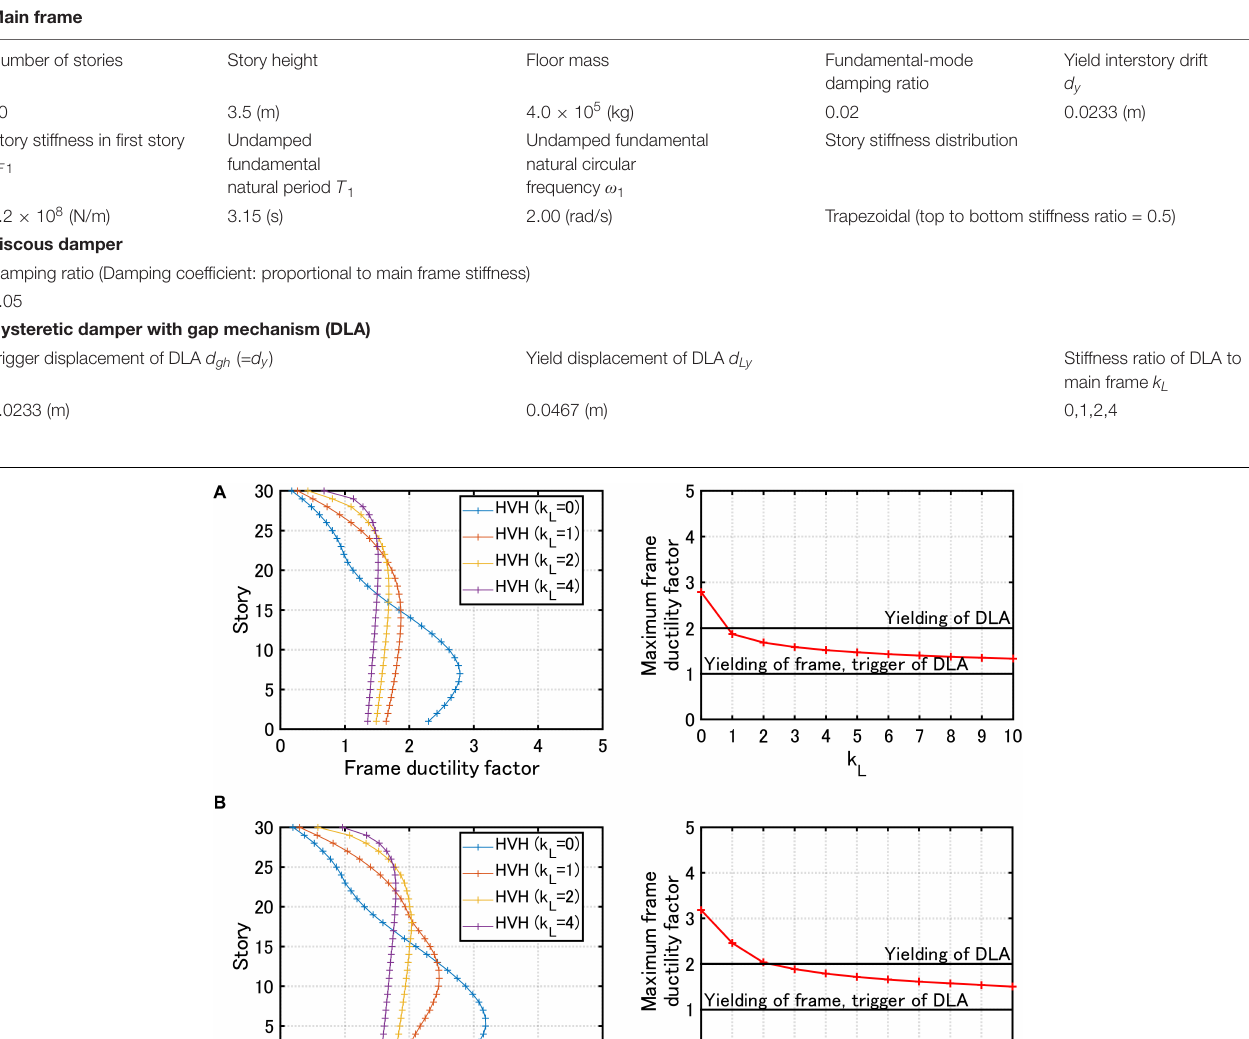
Frontiers in Built Environment |